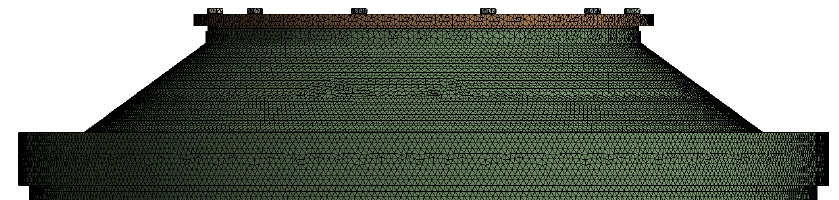
Figure 9. Meshing of space engine finite element